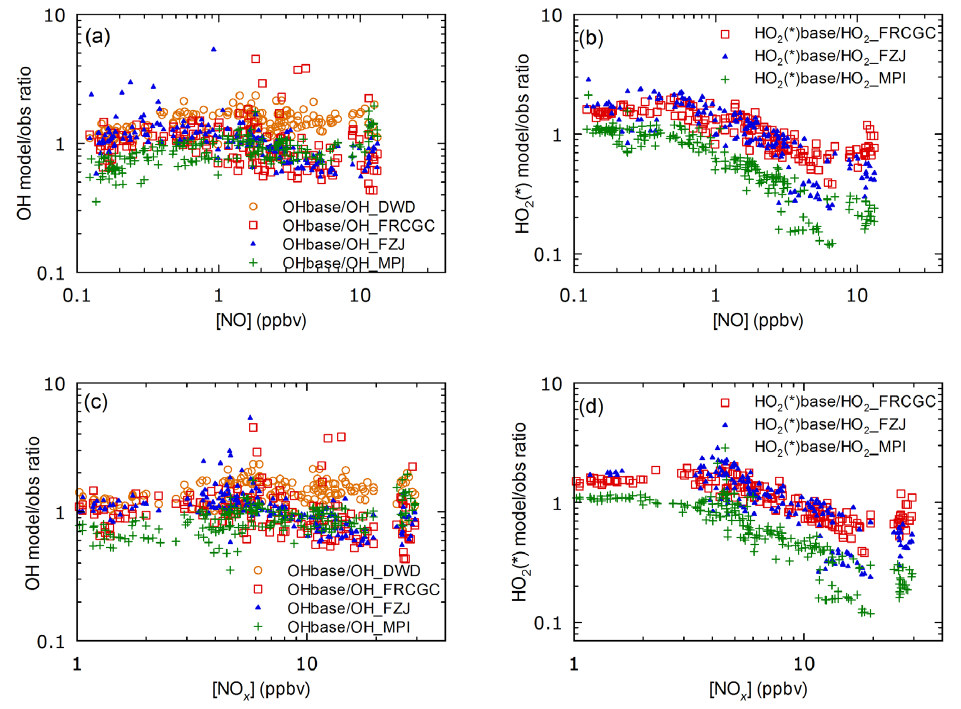
Fig. 9. Model/observation ratios for OH (left) and HO 2 (*) (right) as functions of NO and NO x concentrations for the Base run. Only daytime (06:00–18:00UTC) data are used.